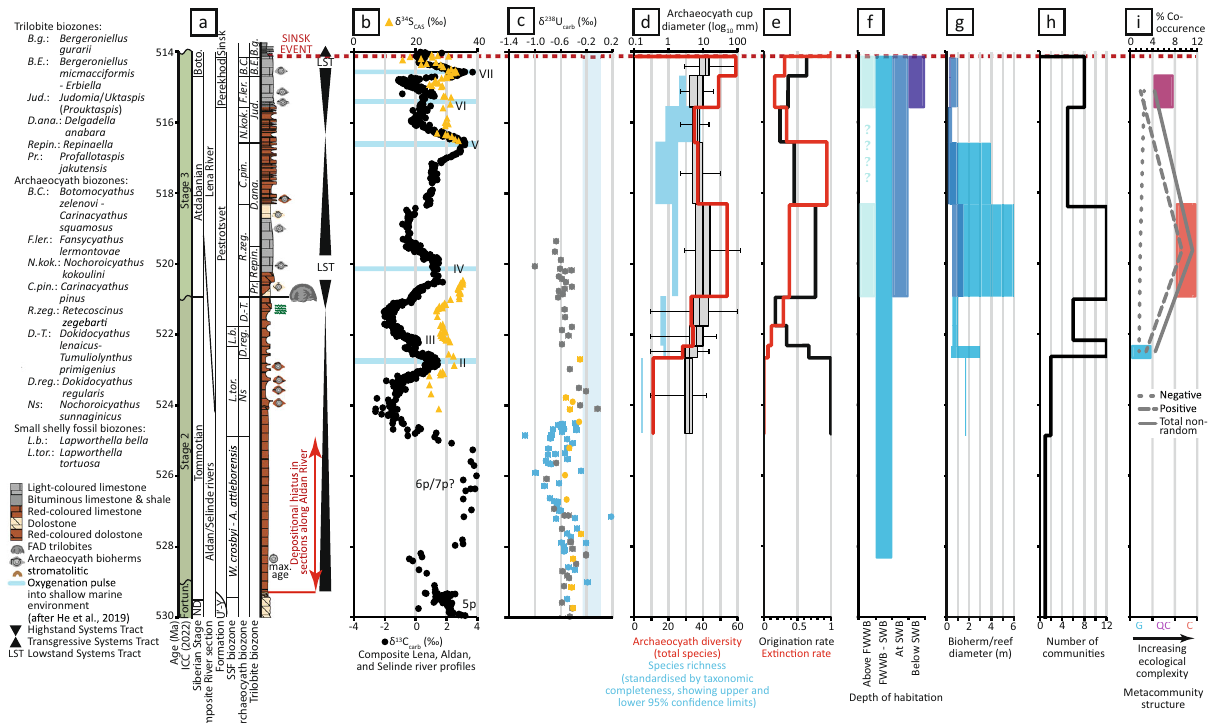
Fig. 3 | Summary of geochemical and biotic changes through the early Cam- brian, Siberian Platform, and uranium isotope data representing a global record. a International and Siberian timescale, within age model C of 57 . ND — Nemakit-Daldynian regional stage; U ’ -Y — Ust ’ -Yudoma Formation. b Summary of carbon and sulphur isotopes (from the Lena River, Siberia 7 ). c Uranium isotopes fromSiberia(grey;SukharikhaandBol ’ shayaKuonamkarivers),SouthChina(blue), andMorocco(orange)(alldatapointsarelargerthan2SE) 4 . d Archaeocyathsponge species diversity and maximum diameter 12 . Plotted richness values are the species richness estimator 21 with accompanying 95% con fi dence interval, calculated using